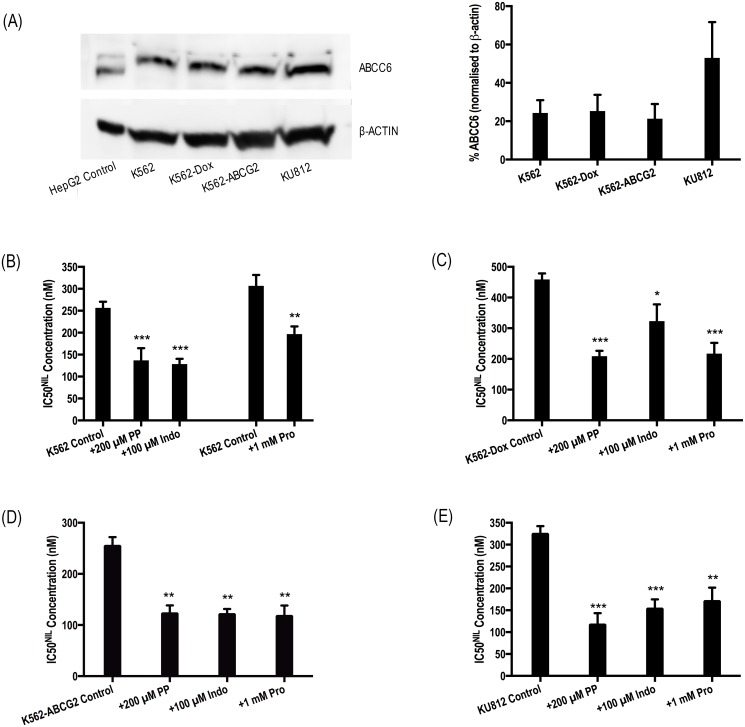
Chemical inhibition of ABCC6 increases the efficacy of nilotinib in BCR-ABL1+ cell lines.(A) Expression levels of ABCC6 protein were assessed in K562, K562-Dox, K562-ABCG2 and KU812 BCR-ABL1+ cell lines. The western blot analyses are representative and the corresponding densitometry analysis represents the mean of three experiments. HepG2 cells were used as a positive control and protein levels were normalised to β-ACTIN. HepG2 cells express two splice variants of ABCC6; BCR-ABL1+ cell lines express the N-glycosylated isoform only. (B) K562 (C) K562-Dox (D) K562-ABCG2 and (E) KU812 cells were incubated with increasing concentrations of nilotinib in the absence and presence of three ABCC6 inhibitors (200 μM pantoprazole, 100 μM indomethacin, 1 mM probenecid). CRKL western blotting was performed to determine the concentration of TKI required for 50% Bcr-Abl kinase inhibition (IC50NIL). Two K562 control bars are shown as experiments in the two groups were performed months apart. Error bars represent SEM. Representative western blots are shown in S2 Fig. NIL = nilotinib; PP = pantoprazole; Indo = Indomethacin; Pro = probenecid.